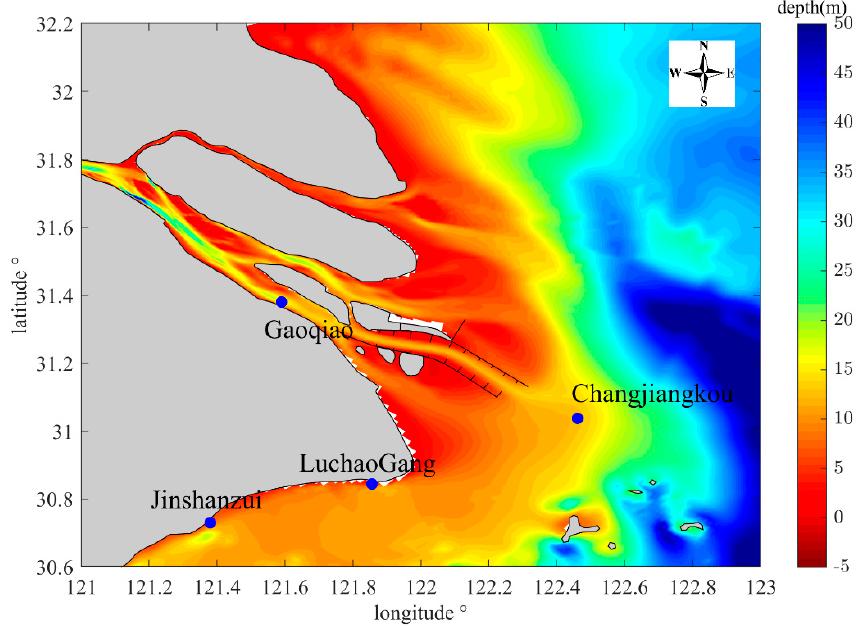
Figure 1. The bathymetry of Yangtze estuary and locations of wind stations.